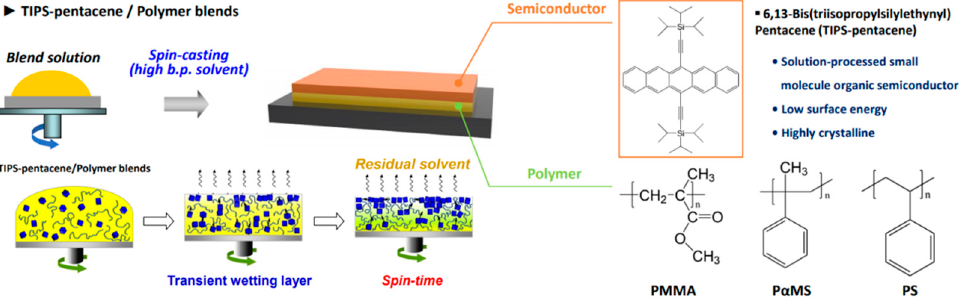
Figure 7. Schematic showing phase-separation behaviors of TIPS-pentacene/polymer blends during the evaporation of the residual solvent [86]. Copyright 2012 Wiley. Typically, a vertically phase- separated structure consisting of TIPS-pentacene at the top and polymer at the bottom is formed on SiO 2 /Si.